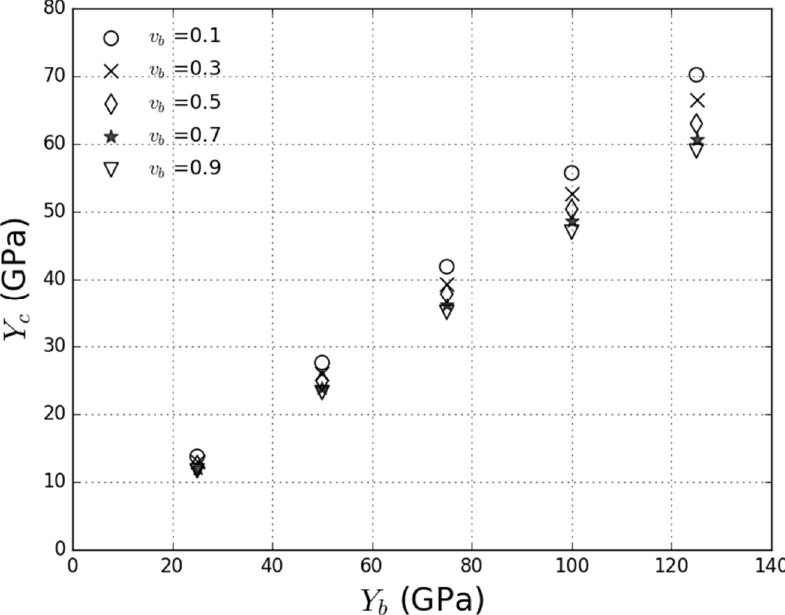
Figure A3. Macroscopic Young’s modulus under compressive loading (Y c ) versus elastic beam modulus (Y b ) of bonded DEM-spheres, for a range of beam Poisson’s ratios.